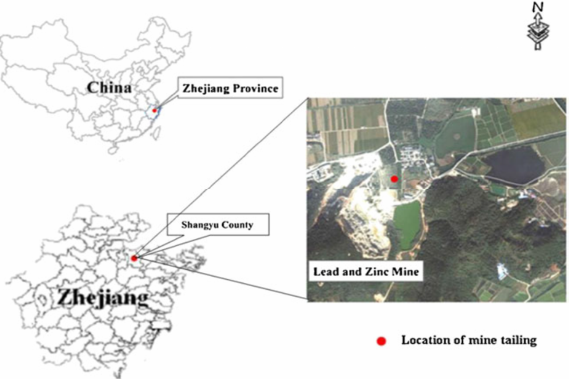
Figure 1. Soil sampling point map.